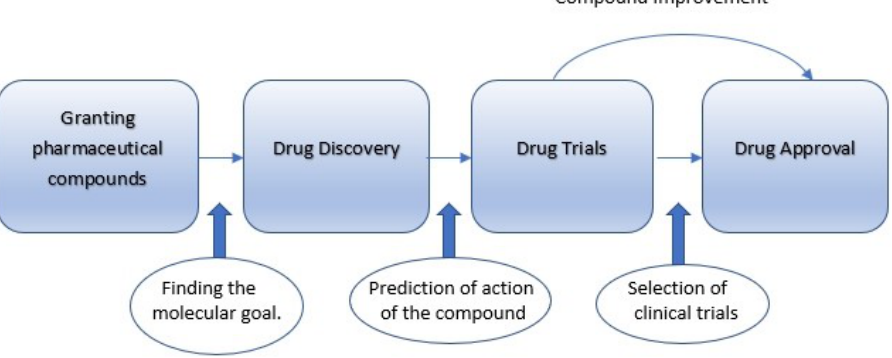
Figure 2. The steps for a drug to be launched in the market.